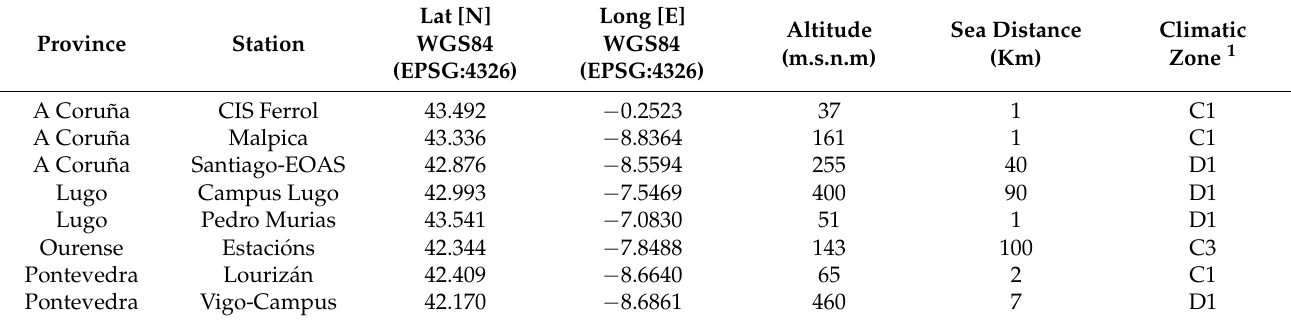
Table 1. Geographical situation of the selected stations.